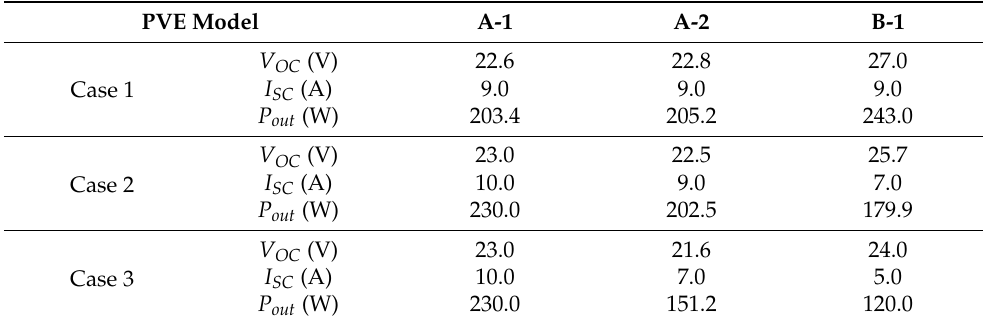
Table 4. Case Study of Partial Shading Using Multiple Series Connections of PVEs.